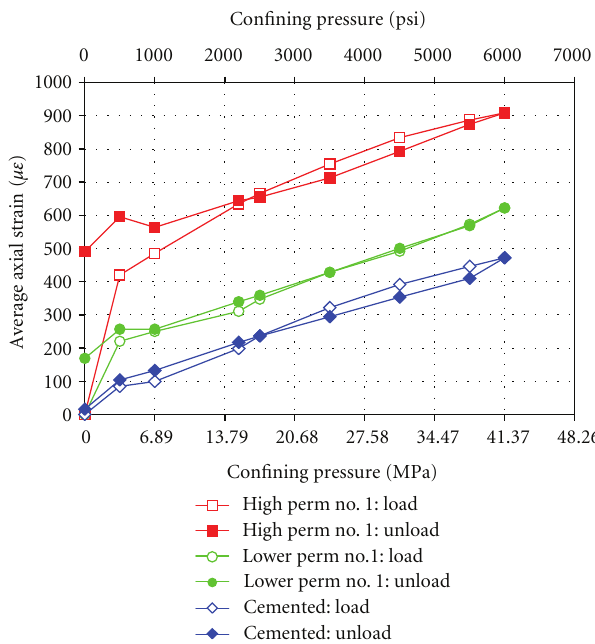
Figure 11: Average axial strain as a function of isostatic confining pressure for three dry rock core